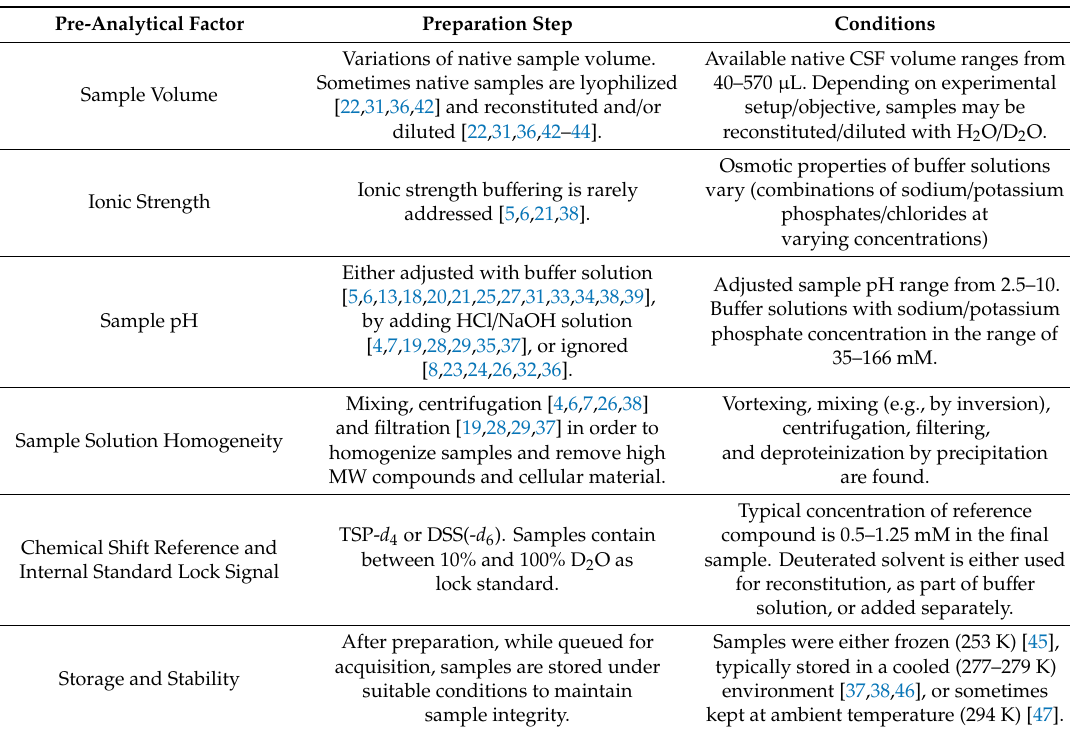
Table 1. Pre-analytical factors and common steps in NMR sample preparation for metabolomic analysis of cerebrospinal fluid (CSF) described in the literature) [4–8,13,18–39].